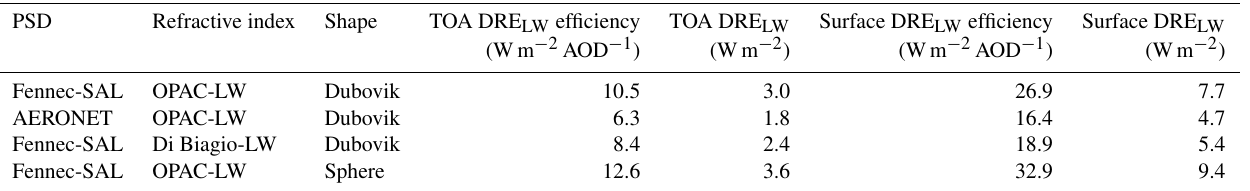
Table 3. Instantaneous DRE LW based on different dust models. Note that the diurnal mean values are almost identical to the instantaneous results due to small diurnal variation in the LW.